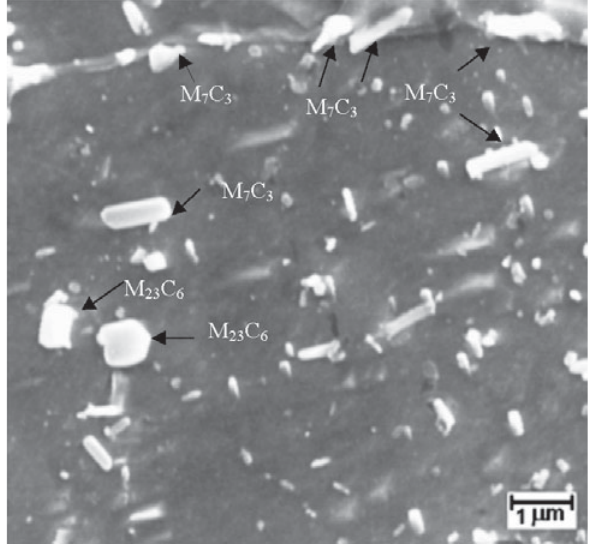
Figure 7. Microstructure of a 2.25Cr – 1.0Mo steel from the pres- sure vessel walls with the service time of 2 years. Carbides are marked by